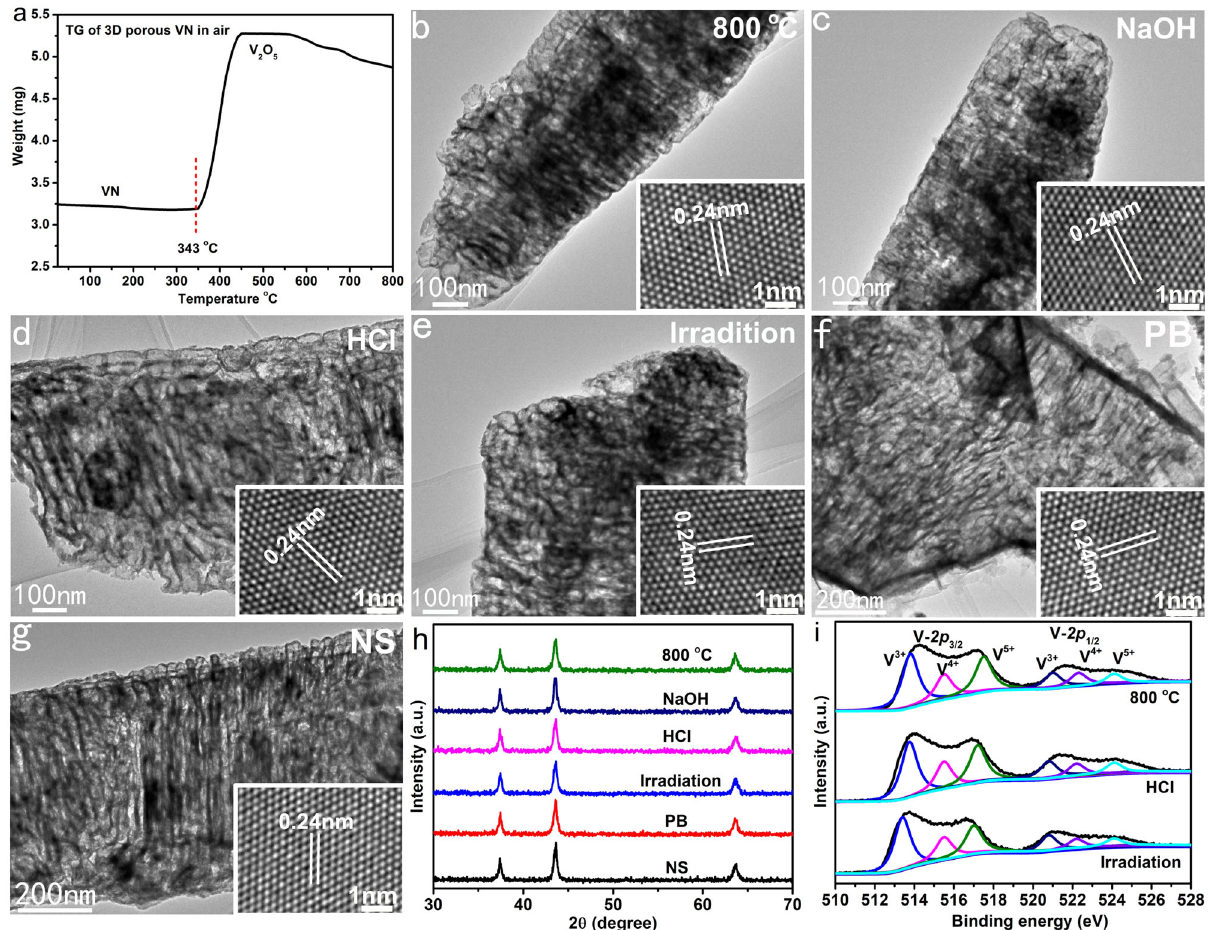
Fig. 5 Thermal, chemical, and light stability of the 3D porous VN. a TG curve. b – g TEM and HRTEM (inset) images recorded from the 3D porous VN treated at different conditions: b 800 °C for 5 h; c 6 M NaOH for 5 h; d 6 M HCl for 5 h; e 20 mW laser (532 nm) for 5 h; f 0.3 M PB for 8 h; g 0.9% NS for 8 h. h XRD patterns of the samples shown in ( b – g ). i XPS spectra of the 3D porous VN treated at different